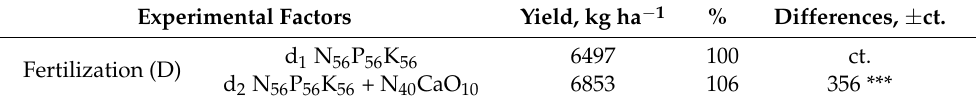
Table 8. Influence of the fertilization on maize average yield, 2016–2021. Experimental Factors Yield, kg ha − 1